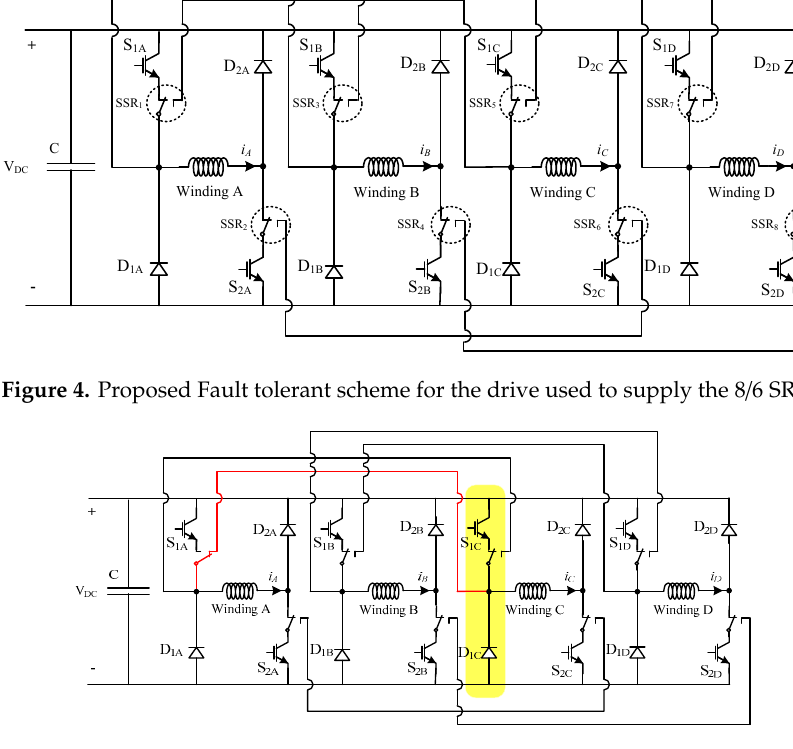
Figure 5. Reconfiguration of the circuit in fault-tolerant mode after a failure (open or short-circuit) in power device S 1 A .